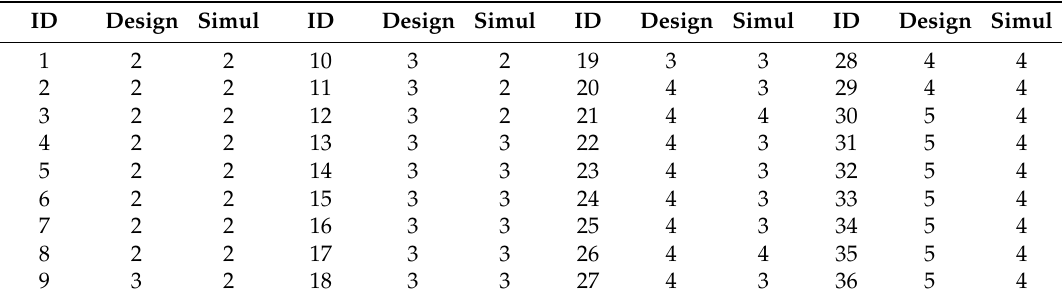
Table 4. Comparing analytical WCRT with that observed in simulation for the Updated_SAE message set with LSW = 55.1% of LEC, considering an Aggressive environment.